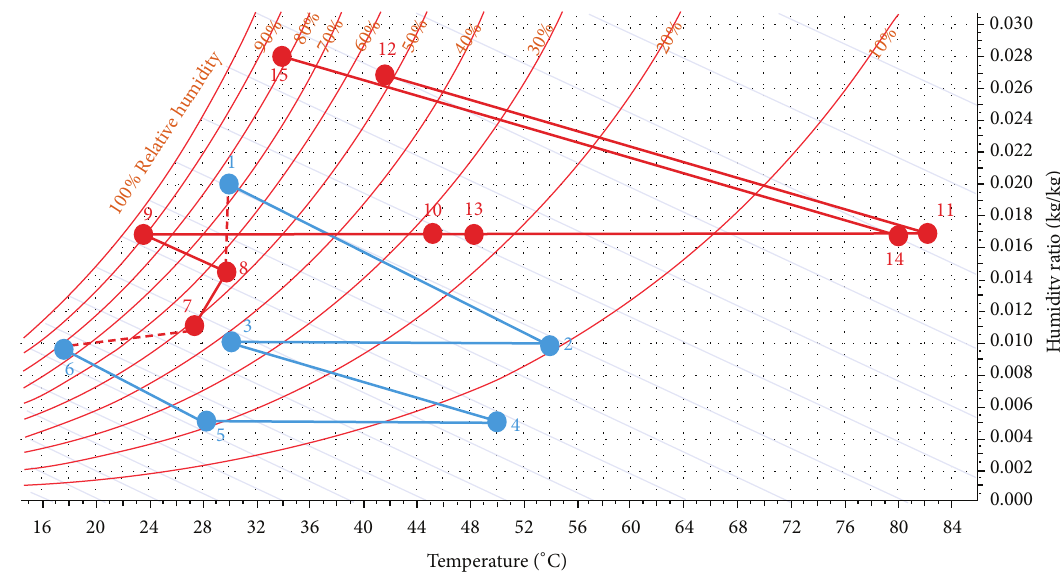
Figure 13: Psychometric chart of two-stage solar desiccant cooling system in ventilation mode.